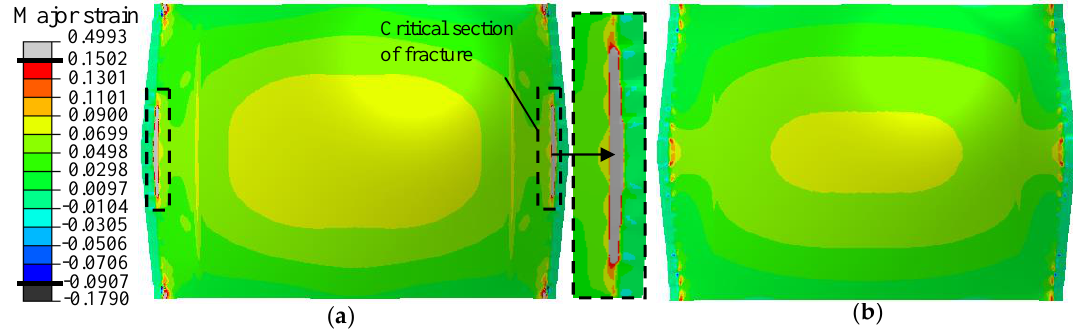
Figure 18. Major strain distributions in stretch-forming process. ( a ) SF-e. ( b ) SF-v.